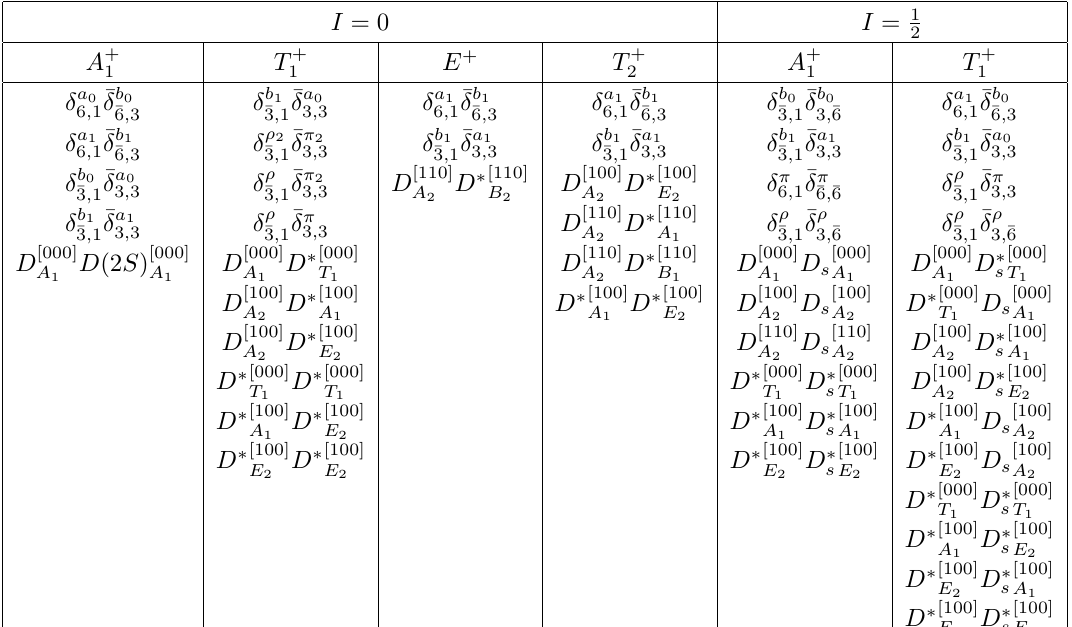
Table 7 . As table 6 but for the doubly-charmed sector with isospin-0 (left columns) and isospin- 1 (right